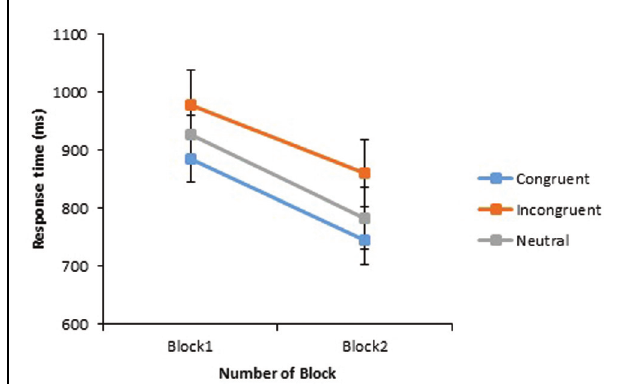
FIGURE 4 | Experiment 2: mean response times (in milliseconds) of correct judgments to critical word pairs across Block 1 and Block 2. The vertical axis begins at 600 ms while error bars indicate the 95% confidence